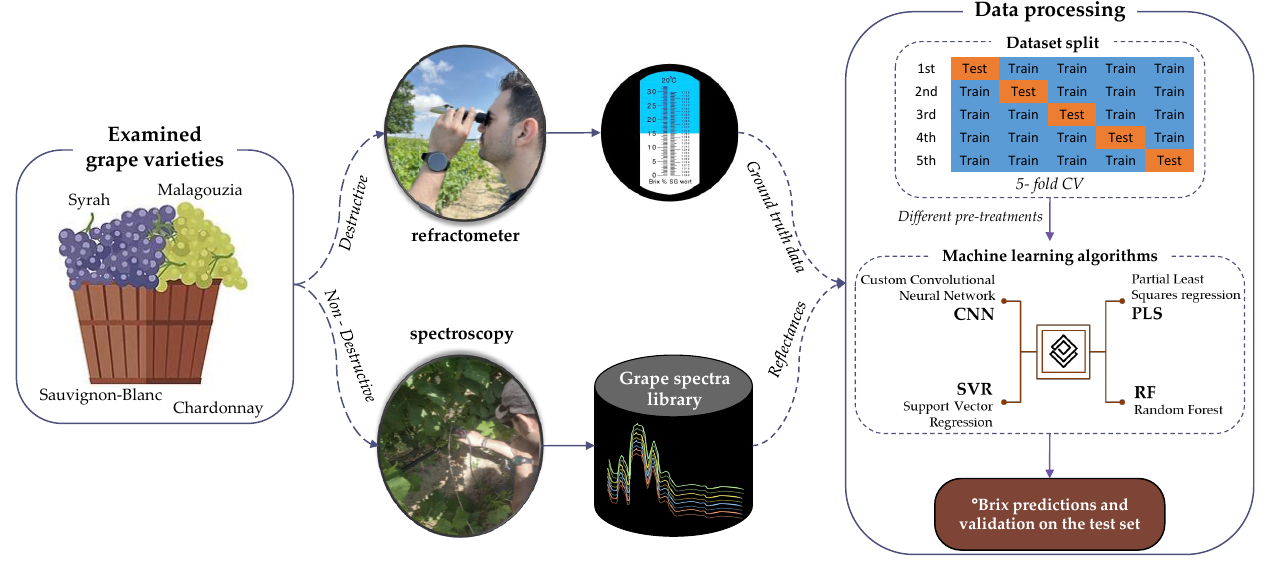
Figure 2. Overall experimental and methodological process adopted in the current